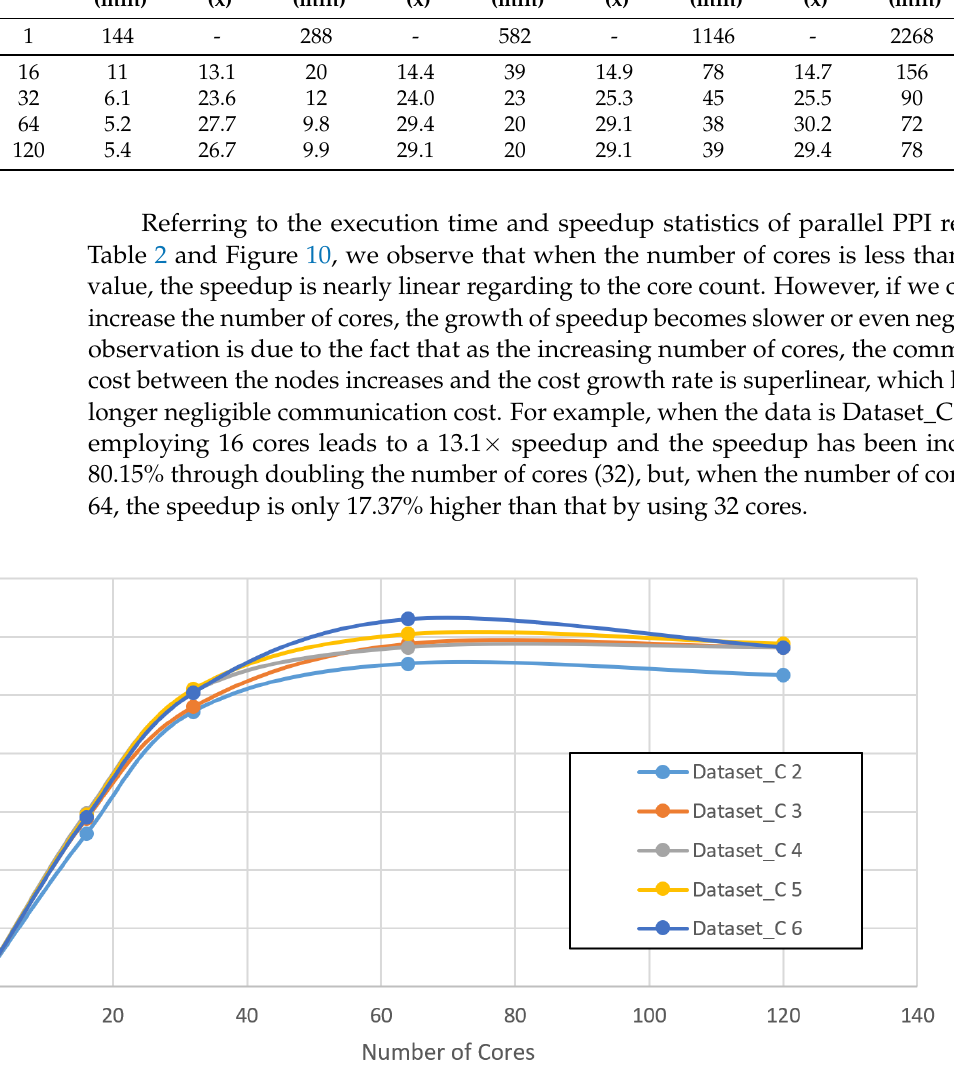
Figure 10. Speedup achieved by the parallel PPI on Spark for various data sizes with different numbers of